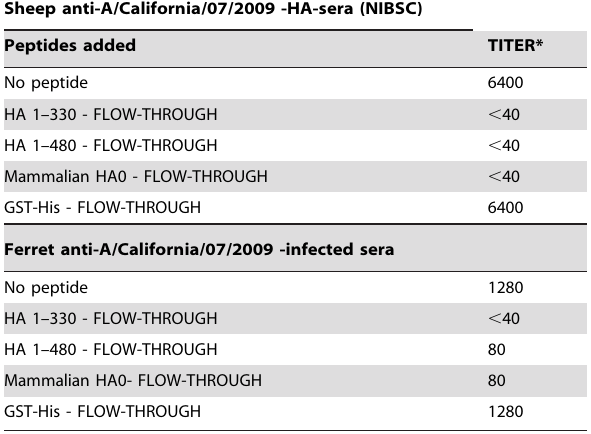
Table 1. Adsorption of neutralization activity using HA proteins.